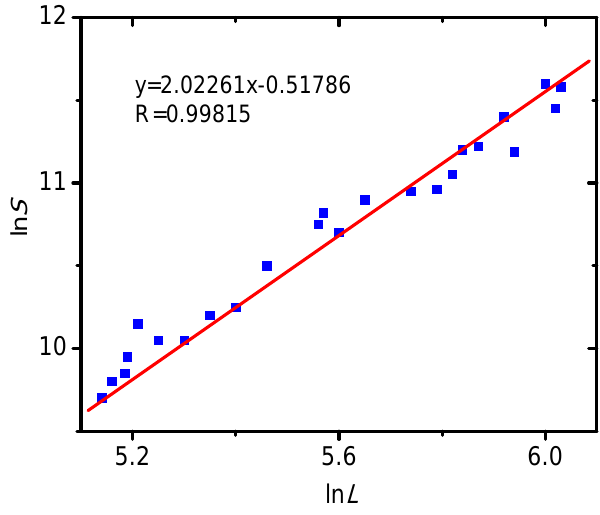
Figure 9. Fractal dimension ( D ) of hematite flocs.